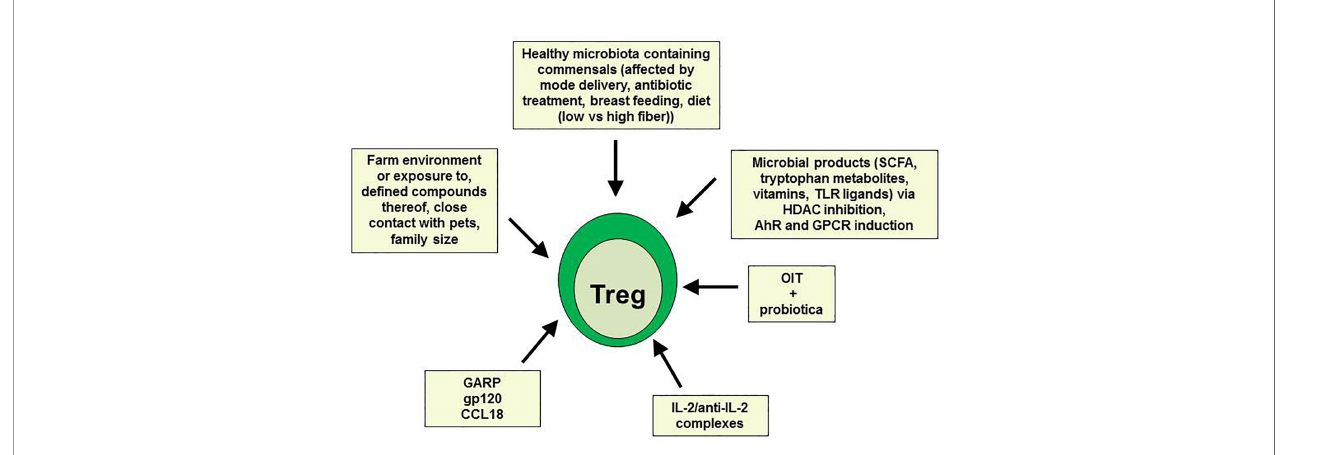
FIGURE 1 | Prevention of type 2 allergic responses by in vivo expansion of